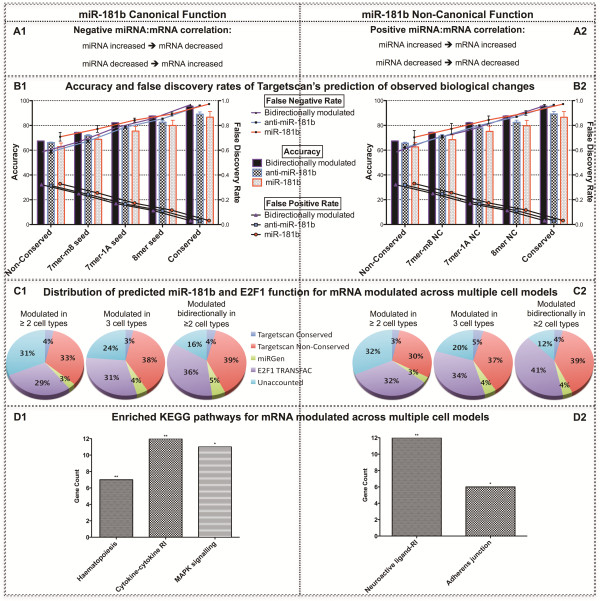
Comparison of canonical (left) and non-canonical (right) miRNA-mRNA relationship. Panel A, scheme. Panel B contains charts of accuracy and false discovery rates associated with Targetscan’s prediction of observed changes in mRNA expression. Panel C, pie charts illustrating the distribution of miR-181b and E2F1 target genes predicted using different algorithms and parameters in multiple cell types. Signal-to-noise ratio is shown to increase for both canonical and non-canonical function as stringency increases from genes modulated by either miR-181b over-expression or inhibition across at least two cell types; to genes modulated by either miR-181b over-expression or inhibition across all three cell types; to genes modulated by both miR-181b over-expression and inhibition across at least two cell types. Panel D contains charts of enriched KEGG pathways from genes modulated by either miR-181b over-expression or inhibition across at least two cell types. RI: receptor interaction. MAPK: mitogen-activated protein kinase.